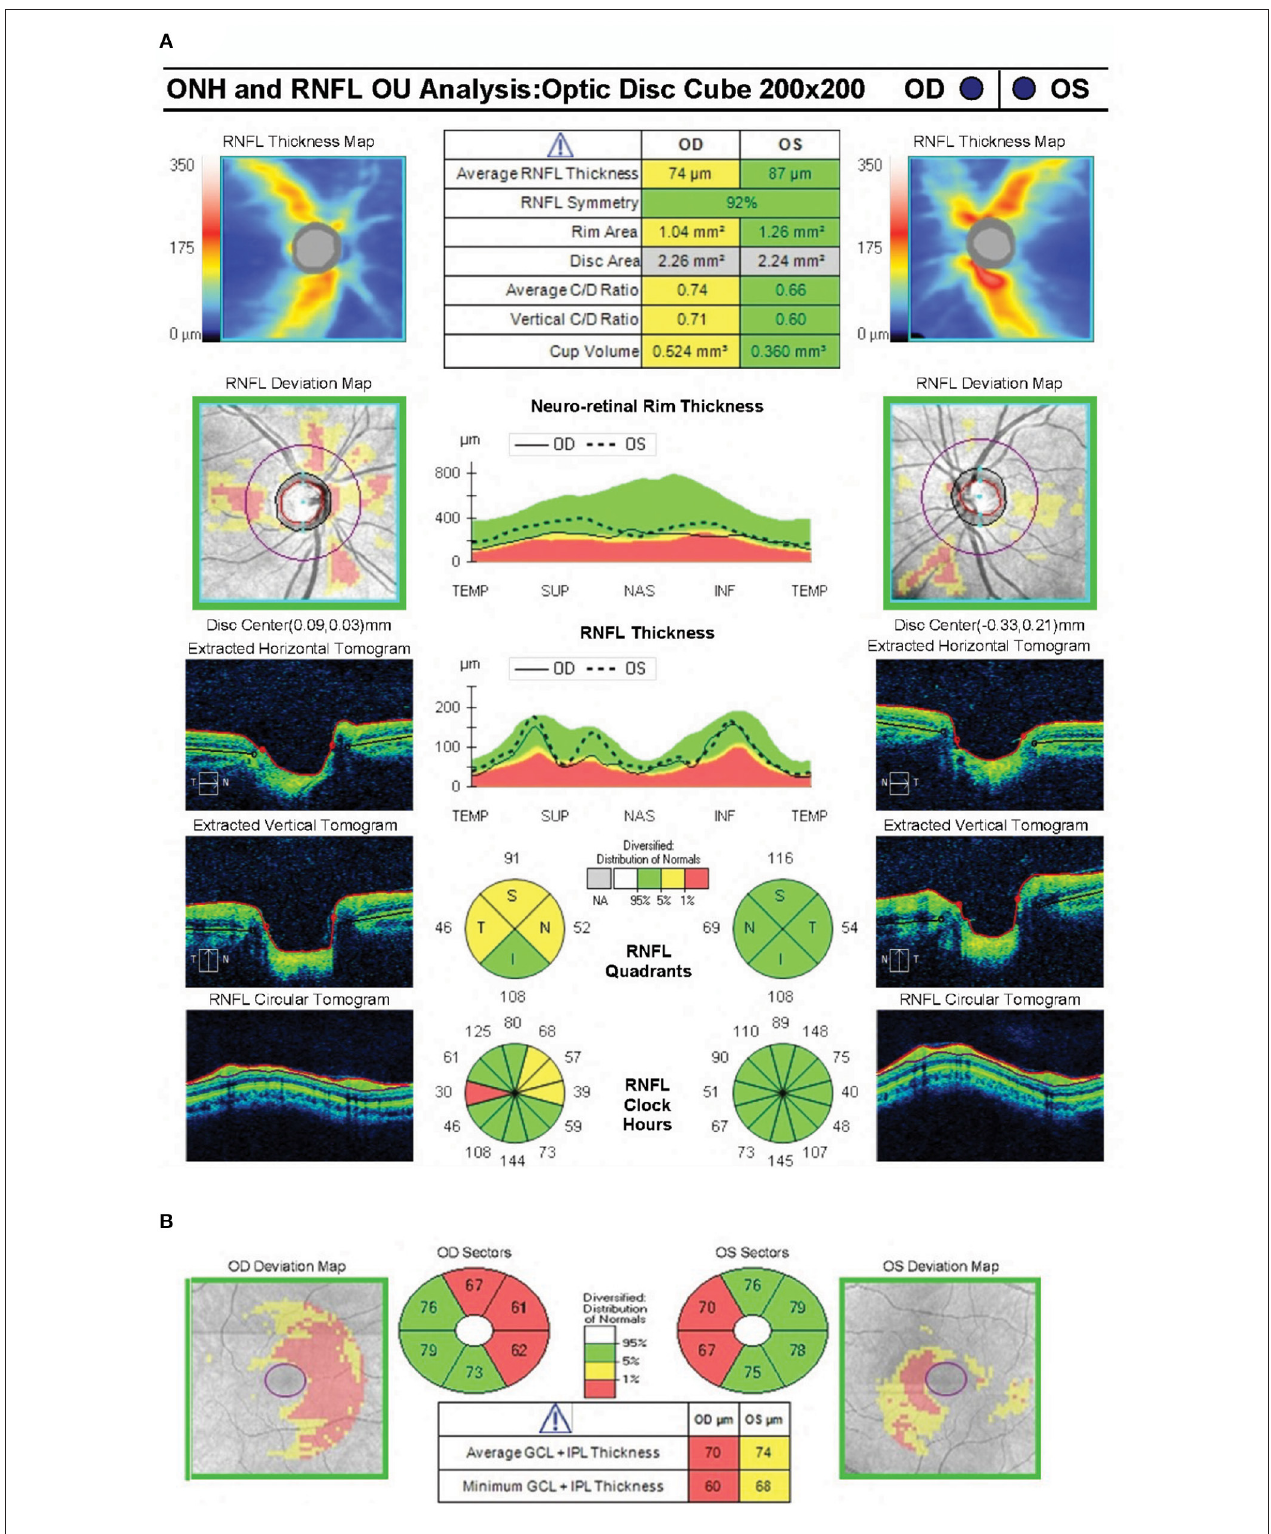
FIGURE 2 | Spectral domain optical coherence tomography showing near normal average peripapillary retinal nerve fiber layer thickness (74 microns) in the right eye and normal average peripapillary retinal nerve fiber layer thickness (87 microns) in the left eye (A) . OCT RNFL shows borderline thinning superiorly, nasally and temporally in the right eye. The ganglion cell complex shows loss of the nasal fibers bilaterally (B) .